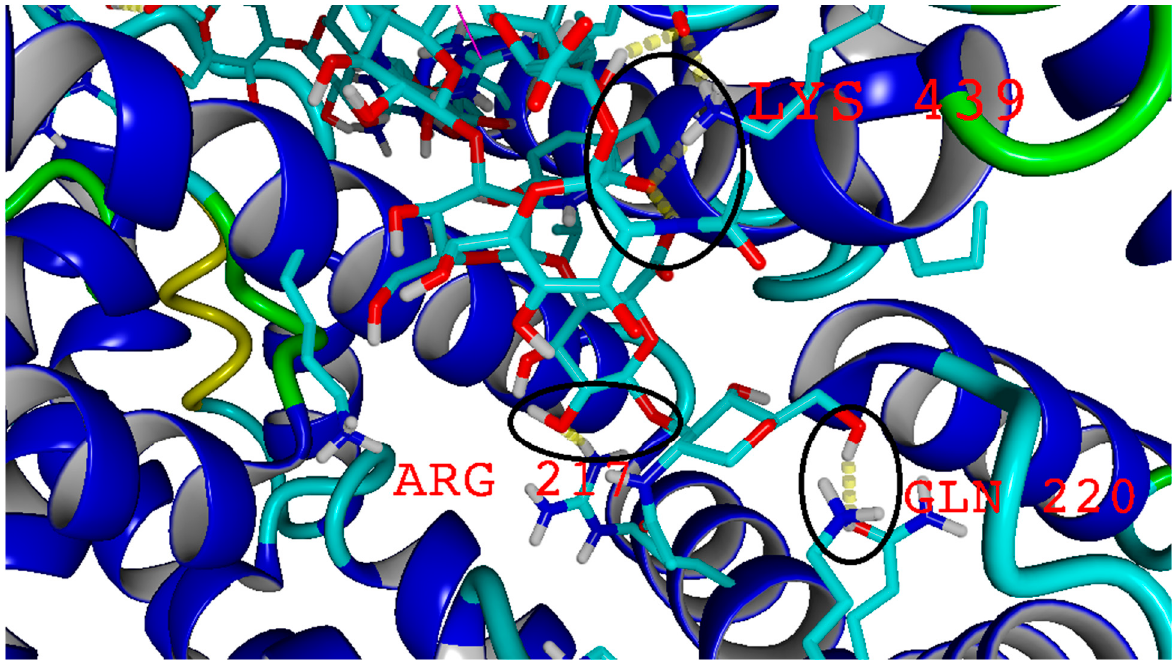
Figure 10. Visualization of hydrogen bonds (yellow dotted lines) inside the BSA–HA complex. Black circles and amino acids forming hydrogen bonds have been added for better visualization.